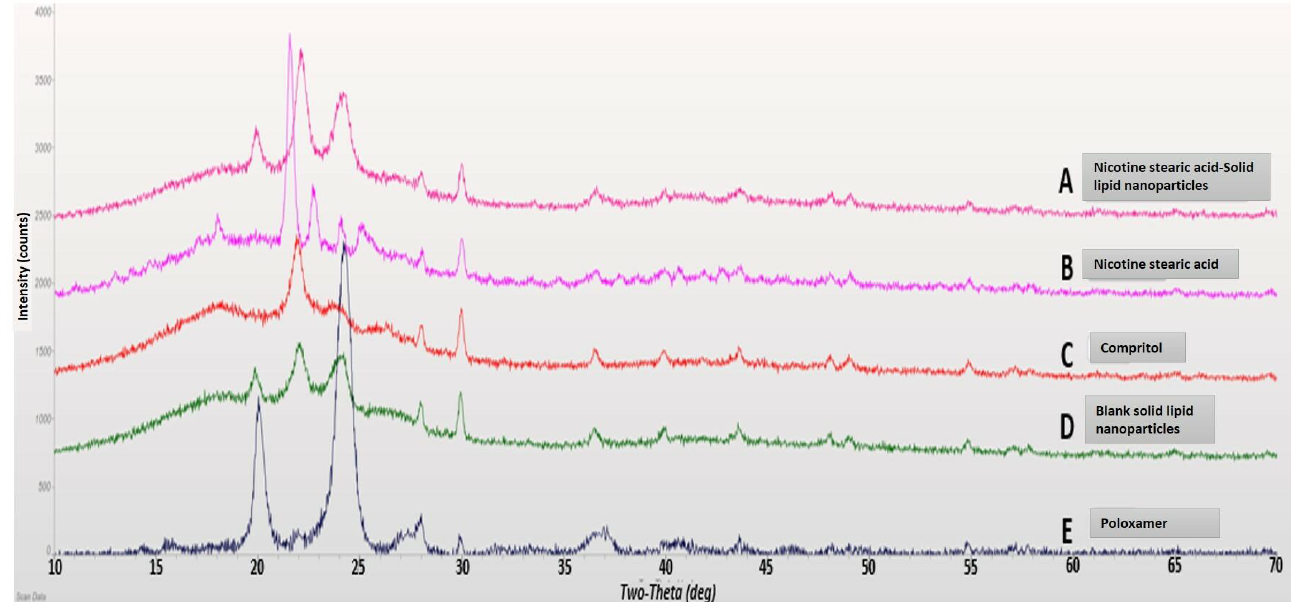
Figure 5. Overlaid XRD pattern: (A) lyophilized nicotine−stearic acid loaded SLNs, (B) nicotine−stearic acid conjugate, (C) Compritol 888 ATO, (D) blank SLNs, and (E) Poloxamer 188.